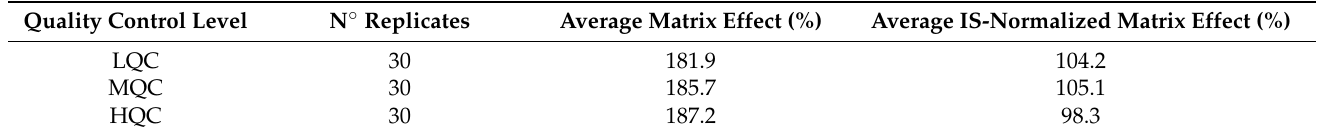
Table 4. Average (Avg) Matrix effect (ME%) and Recovery (ER%) of C measured at different concen- tration levels.